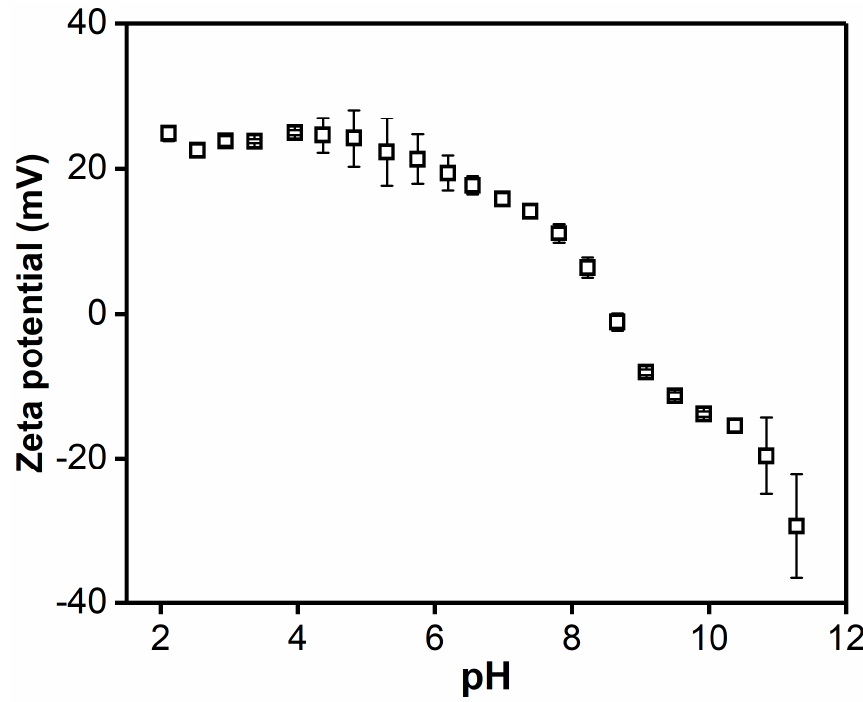
Figure 3. Zeta potential of the PSaMA NF membranes at different pH values calculated using the Fairbrother and Mastin (FM) method measured from low to high pH values. The error bars indicate the standard deviation of 4 measurements on a single membrane sample.